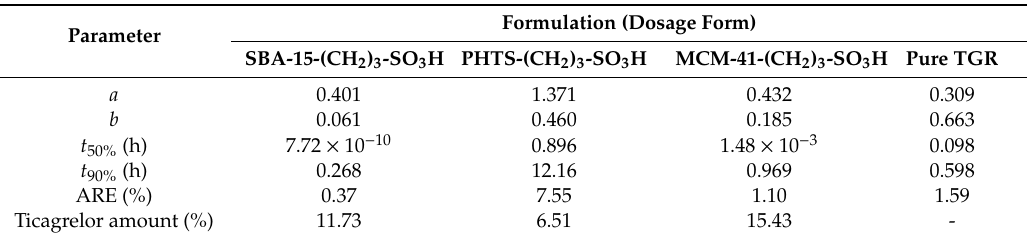
Figure 11. Profiles of cumulative release of ticagrelor from various mesoporous carriers. Medium: acetate bu ff er (pH 4.5) containing 0.5% (m / v) SDS addition. Table 4. Weibull equation parameters calculated for ticagrelor release from various mesoporous matrices in acetate bu ff er pH = 4.5 with 0.5% SDS